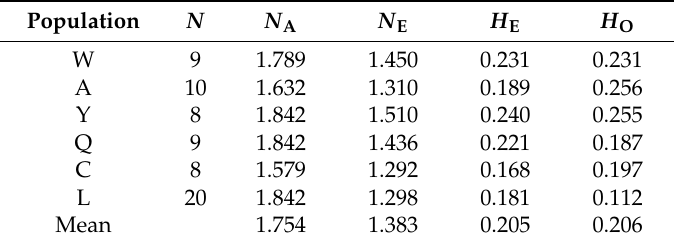
Table 4. Genetic diversity parameters of six natural populations of P. bungeana